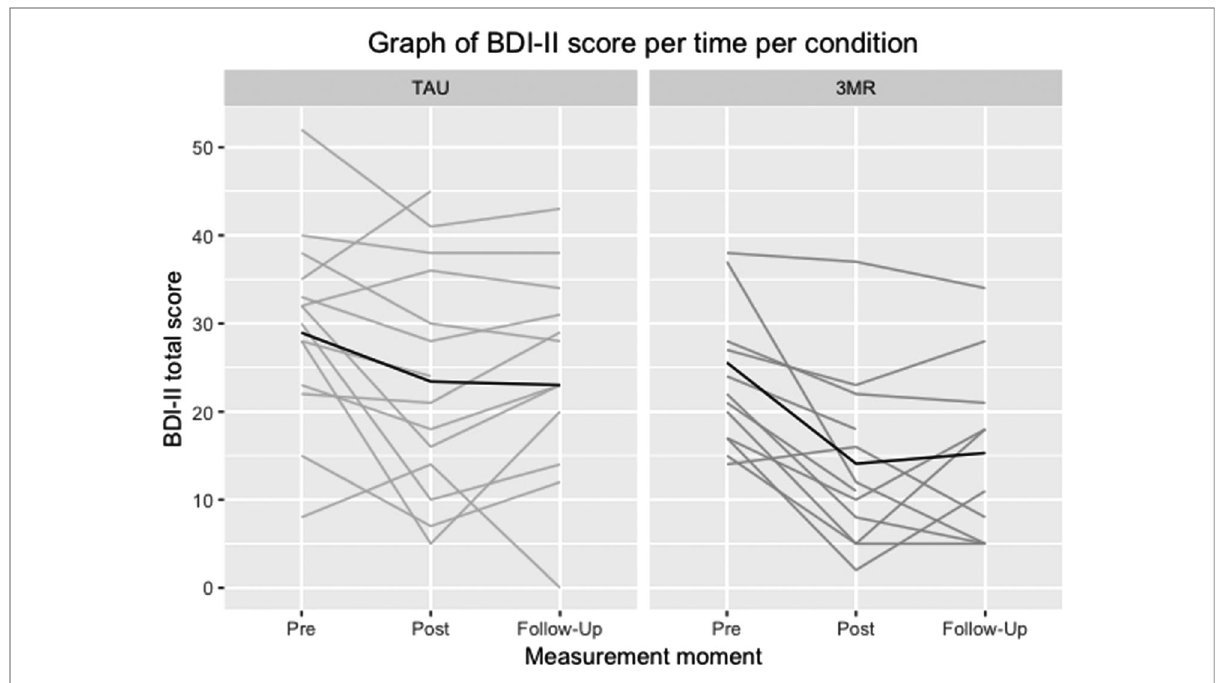
FIGURE 3 Individual patient trajectories over time for the BDI-II in both treatment conditions, with the dark line representing the mean